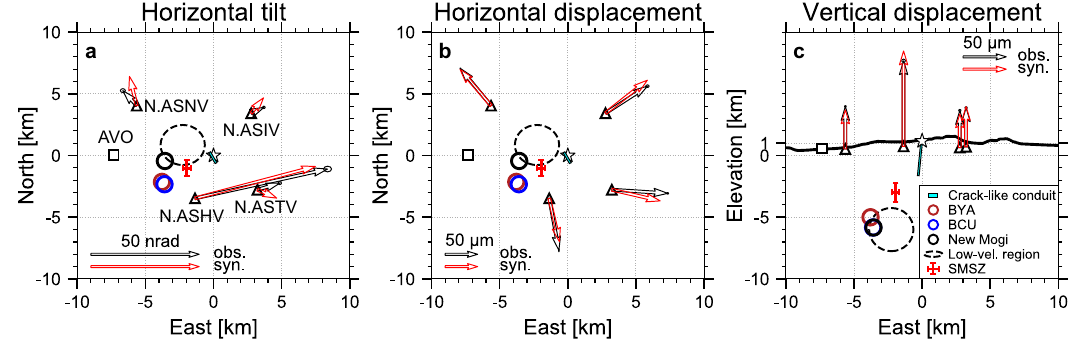
Fig. 3 Source inversion result. a – c Comparisons between observations (black arrows) and synthetics (red arrows) predicted from the inverted source location and mechanism. Red cross marks the inverted source location with uncertainties of 99.7% con fi dence interval and it corresponds to the shallow magma storage zone (SMSZ). BYA, BCU, New Mogi: magma chambers inferred from geodetic studies 45,46 (see also Fig. 1a); AVO: Aso Volcano